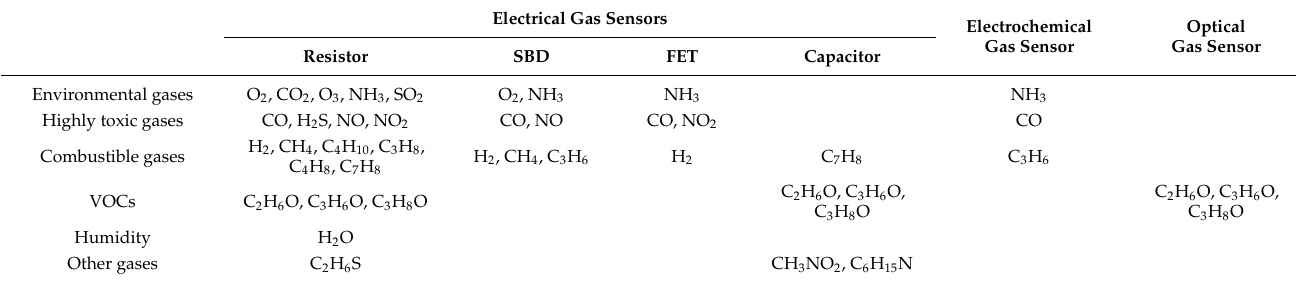
Table 3. Target gases of Ga 2 O 3 -based gas